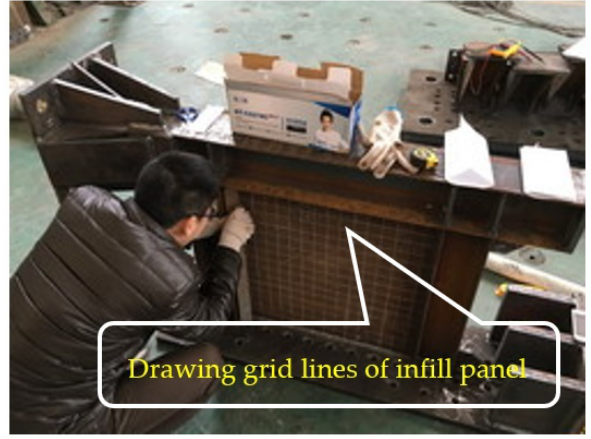
Figure 12. Drawing grid lines of infill panel for specimen 1.